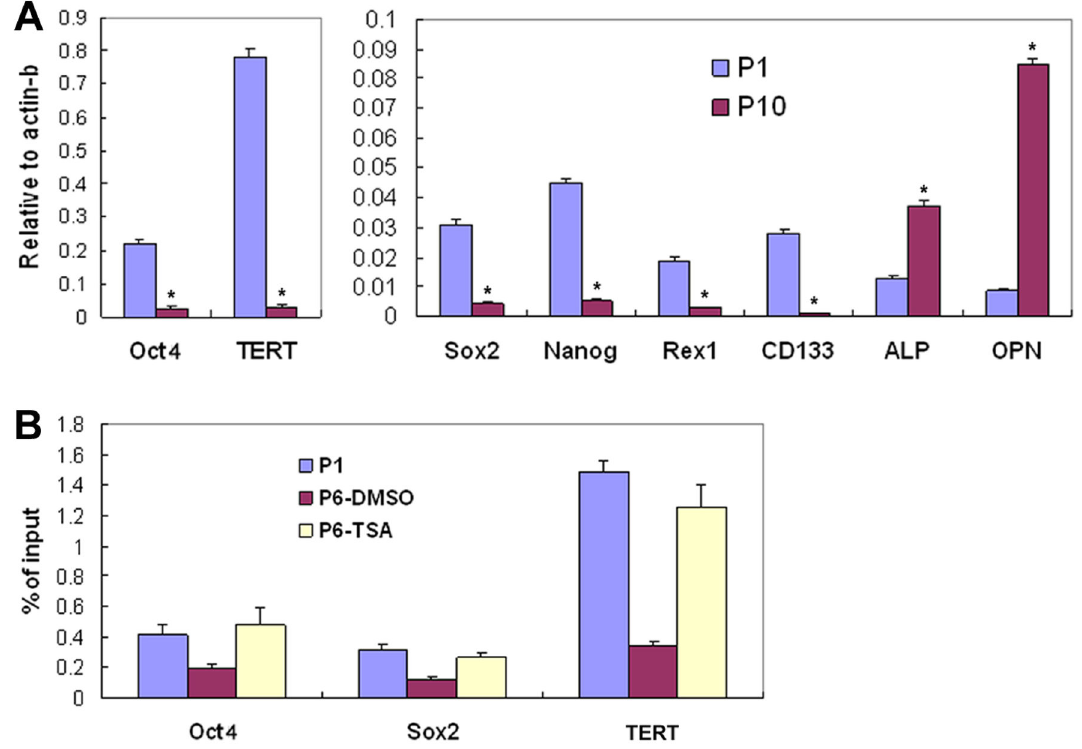
Figure 5. Influence of TSA on the expression and histone H3 acetylation of pluripotent gene in hMSCs. Passage (P)1 hMSCs were grown in the presence of TSA (at 6.25 nM) or vehicle DMSO to passage 6. (A) Real-Time PCR analysis of Oct4, TERT, Sox2, Nanog, REX1 and CD133 genes of the cells in P1 and P6 (A, n=3, * P <0.01 when P6-DMSO compared to P1 and to P6-TSA). (B) Acetylation of histone H3 in K9 and K14 in Oct4, Sox2 and TERT genes in DMSO- or TSA-treated hMSCs (* P <0.01 when P6-DMSO compared to P1 and to P6-TSA). The experiments were repeated three times with similar results.